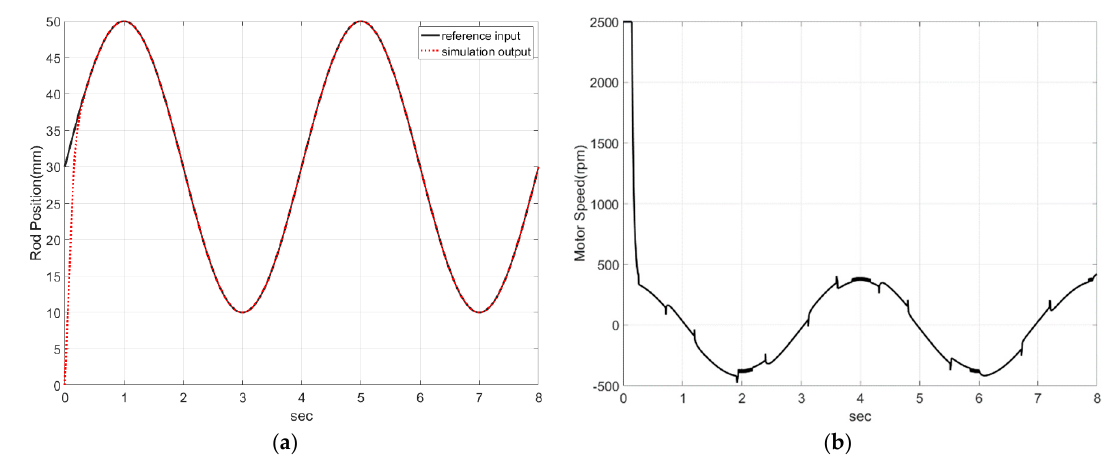
Figure 11. Simulation result of the sliding mode control scheme: ( a ) is the result of position performance, and ( b ) is the speed of the motor. Table 4. The parameters of the control for each experiment. Table 3. The parameters of the cylinder and